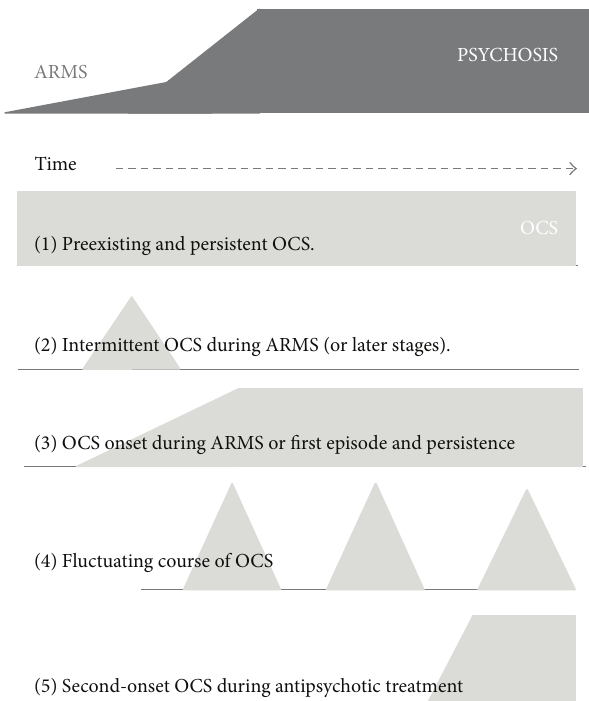
Figure 2: Schematic diagram on onset and course of OCS related to stages of schizophrenia. Bright-gray symbols indicate the onset and severity of OCS, dark-gray symbols are related to the at-risk mental state of psychosis (ARMS), the upcoming first episode of schizophrenia or its chronic course. (1) Preexisting and persistent OCS. (2) Intermittent OCS during ARMS or later in the clinical course. (3) OCS onset during ARMS and persistent course, strongly associated with the psychotic symptoms (schizo-obsessive concept). (4) Fluctuating course of OCS. (5) Second-onset OCS during antipsychotic